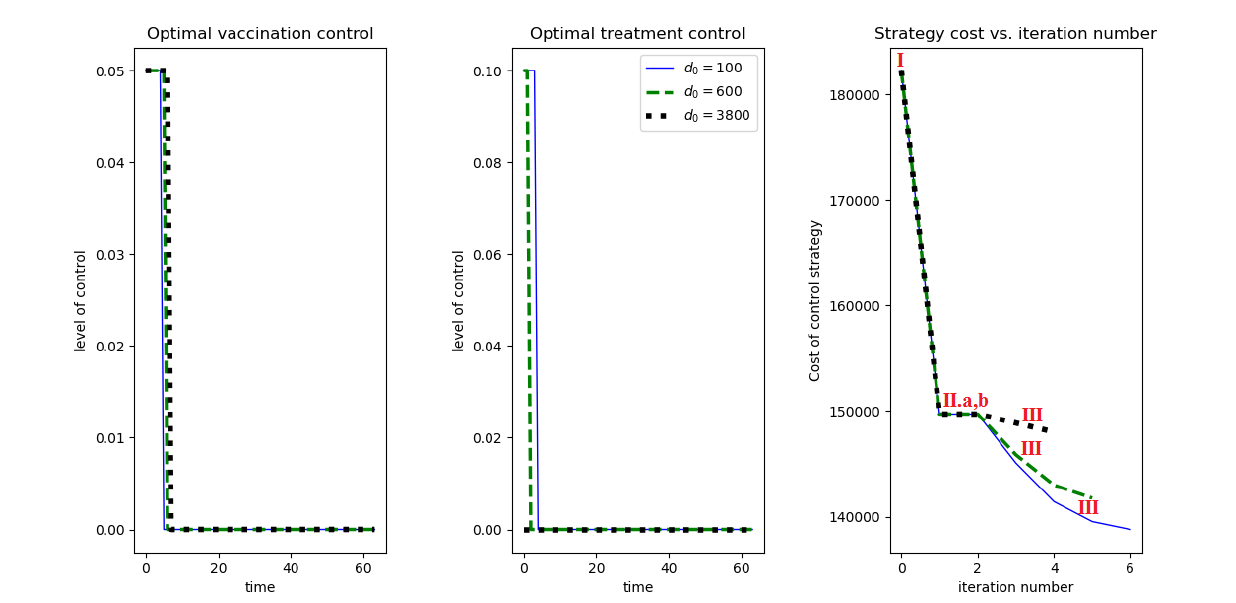
Figure 11. Optimal vaccination, treatment controls and strategy cost for different values of d 0